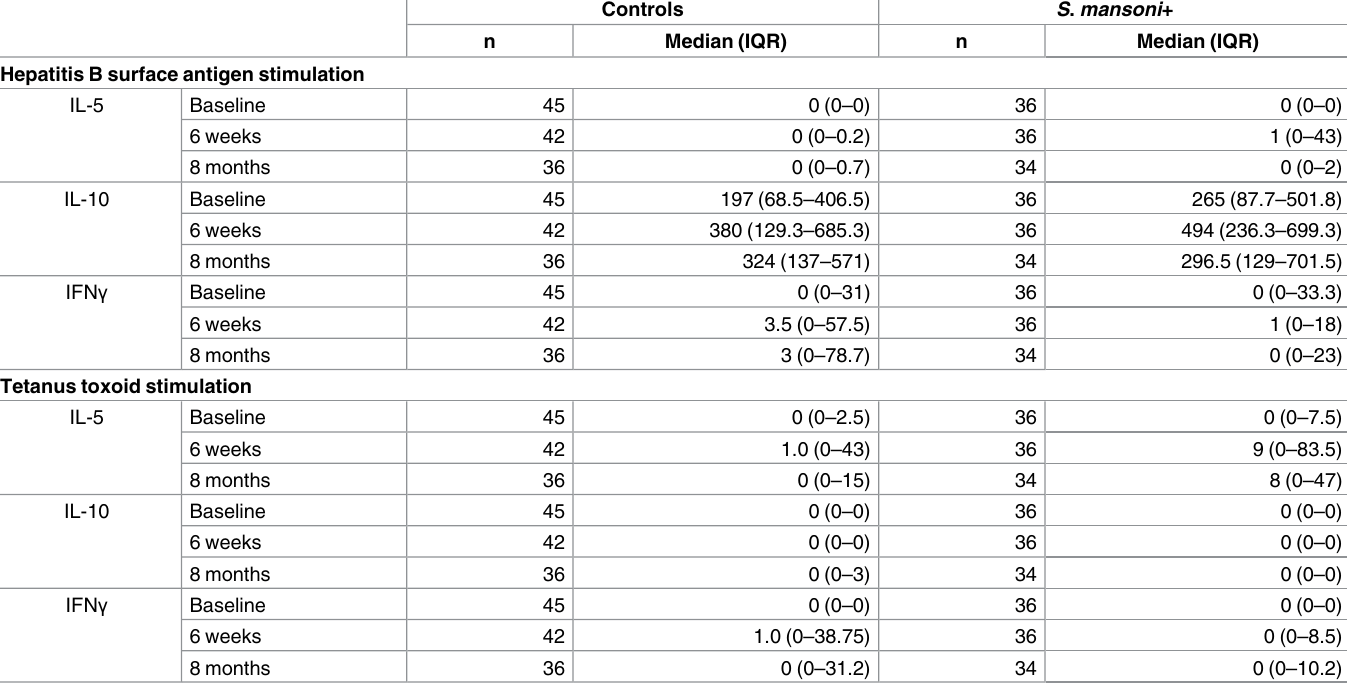
Table 3. Median and Interquartile Range (IQR, 25 th - 75 th percentile) of cytokine response (pg/ml) to 3 day whole blood culture with either tetanus toxoid or hepatitis B surface antigen. Controls S . mansoni